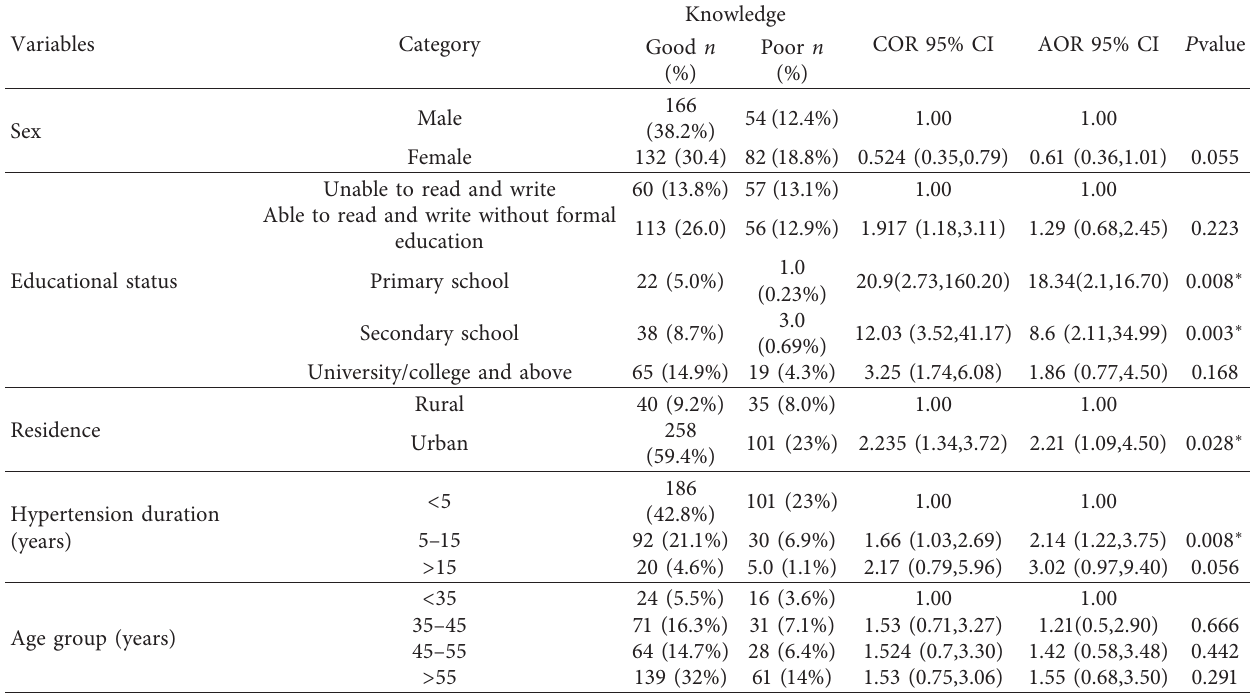
Table 4: Bivariate and multivariate analysis of factors associated with knowledge towards